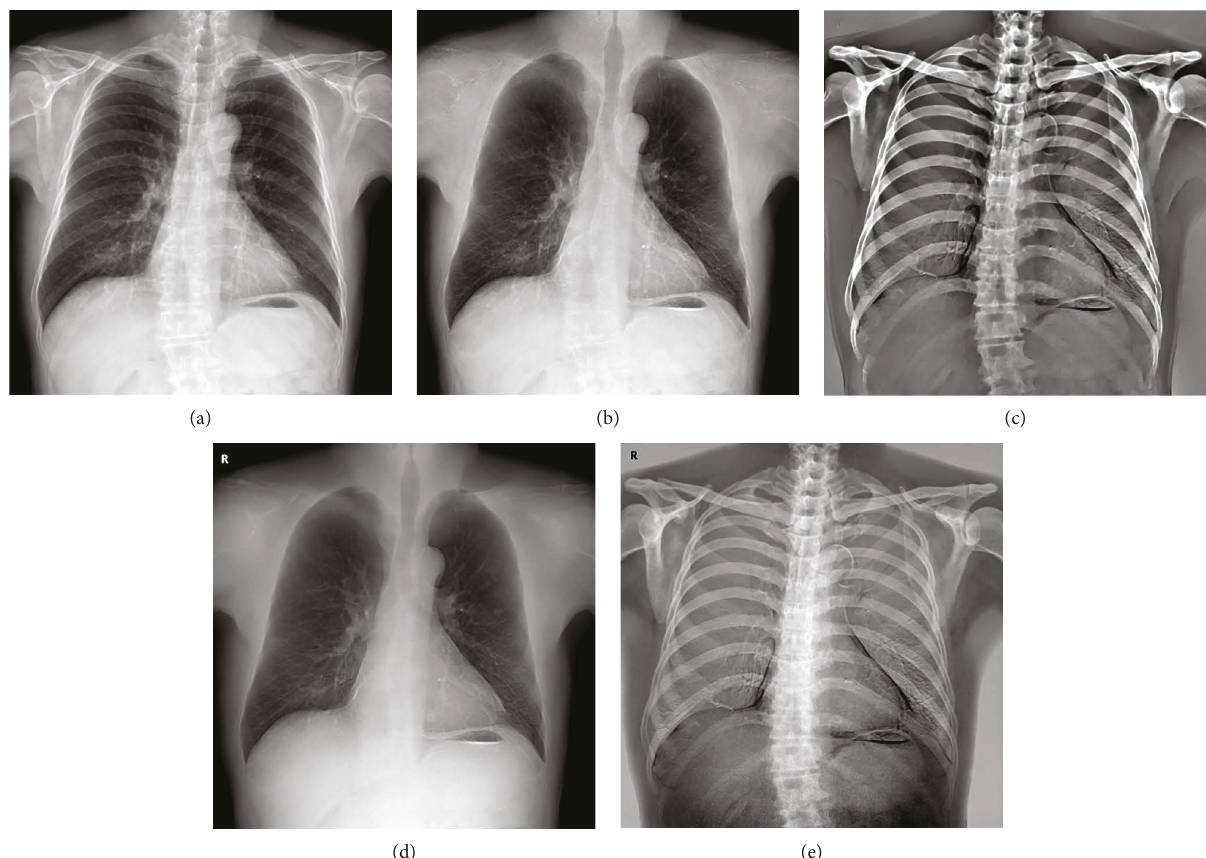
Figure 1: An example of the processed DES training set: (a) the standard chest radiograph; (b) the processed DES soft tissue image; (c) the processed DES bone image; (d) the soft tissue image directly obtained by the DES system; (e) the bone image directly obtained by the DES